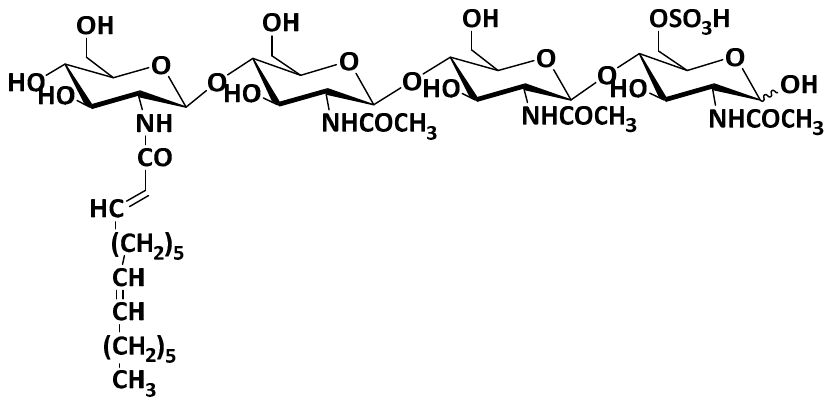
Figure 8. Structure of lipo-chitooligosaccharides produced by EJ355 strain from S. meliloti [159].